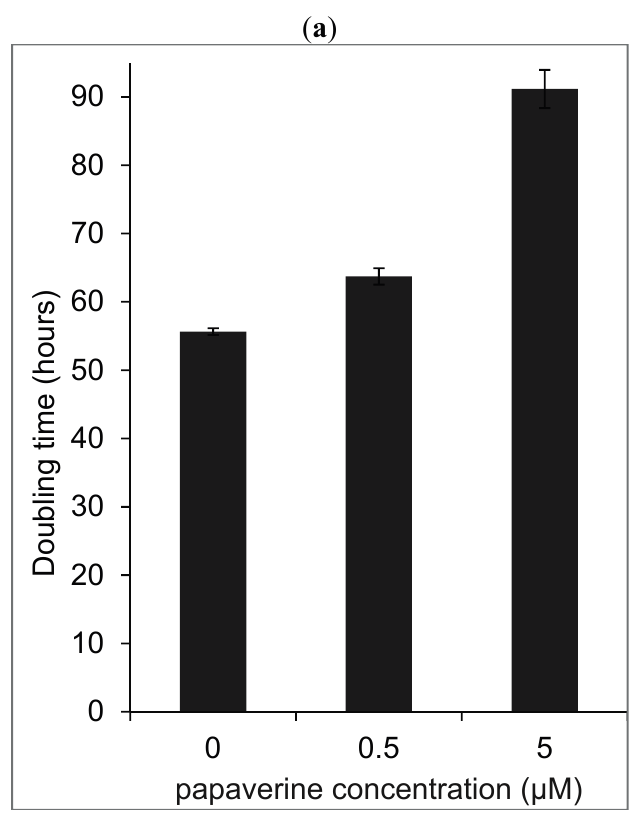
Figure 6. Influence of papaverine treatment on cell doubling time. ( a ) The doubling time, ( b ) number of doublings and ( c ) population size of untreated control HepG2 and treated cells with 0.5 and 5 µM papaverine after 41 days. Presented data are means ± SD of two independent experiments each in